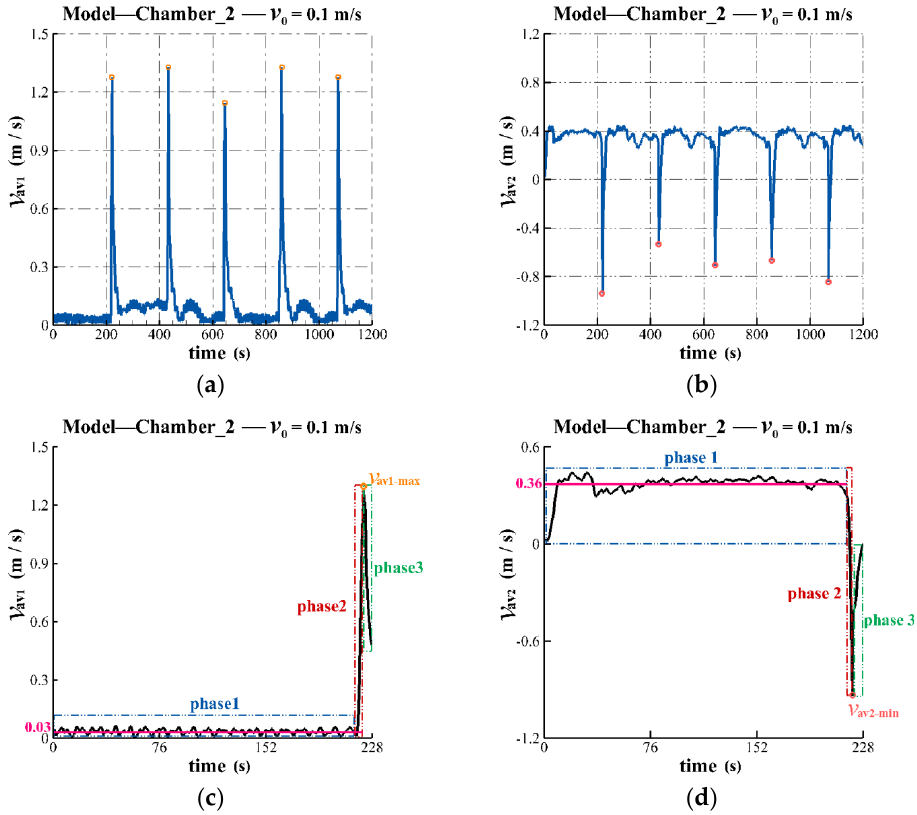
Figure 7. Distribution of the velocity in the outlet of the ascending tube and deflector plate for Working Condition 1. Velocity variation diagram for the ( a ) ascending tube (five cycles) and ( b ) deflector plate (five cycles). ( c ) First cycle of the ascending tube and ( d ) first cycle of the deflector plate.